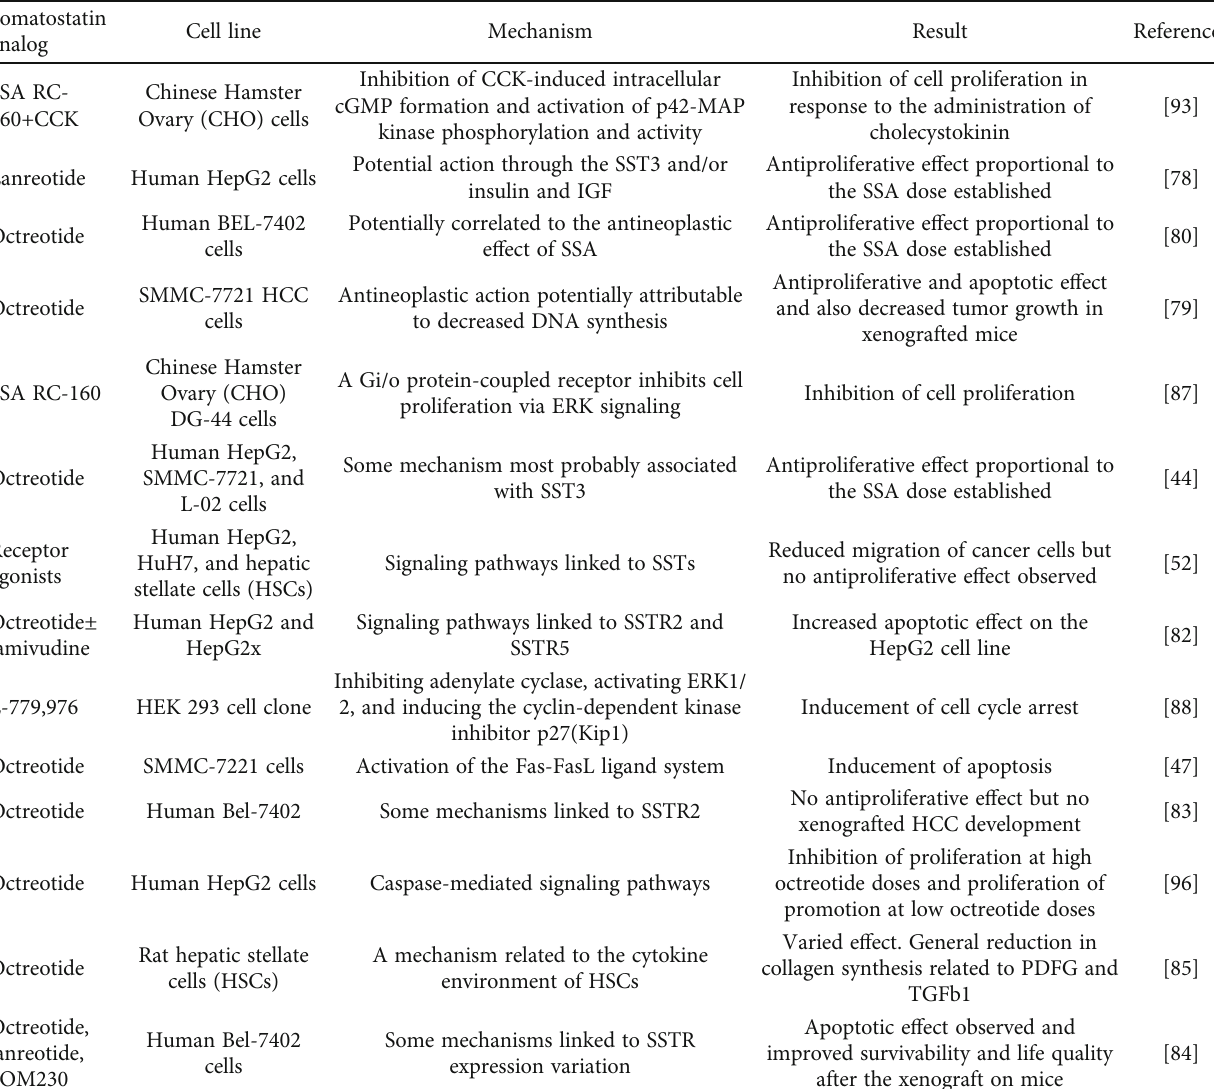
Table 3: In vitro experiments with SSAs and their